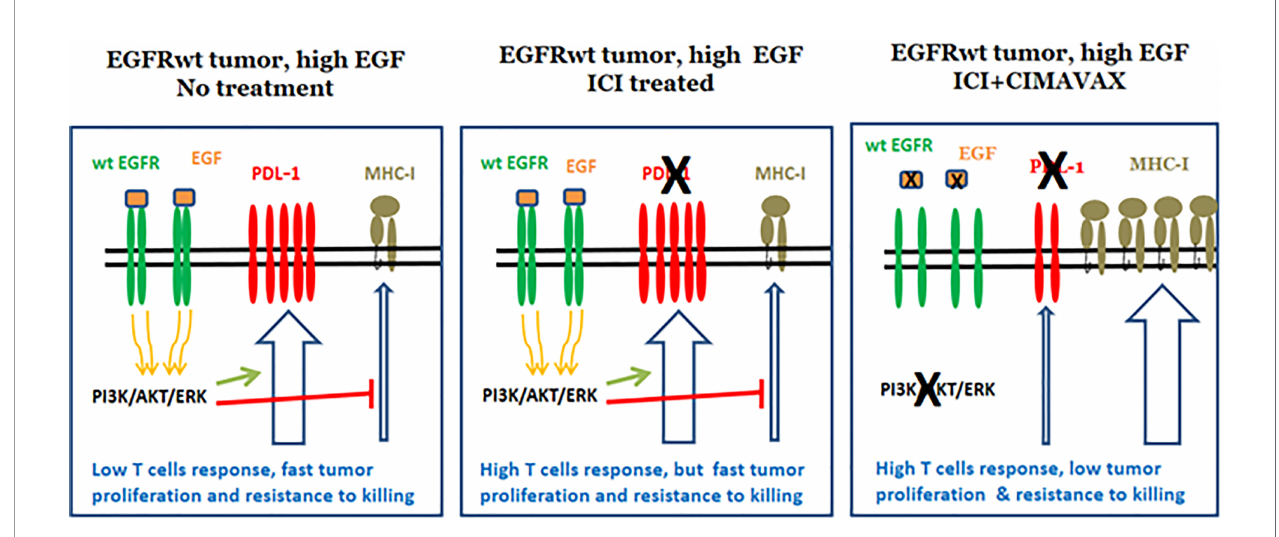
FIGURE 7 | Reduction of PD-L1 expression after EGF